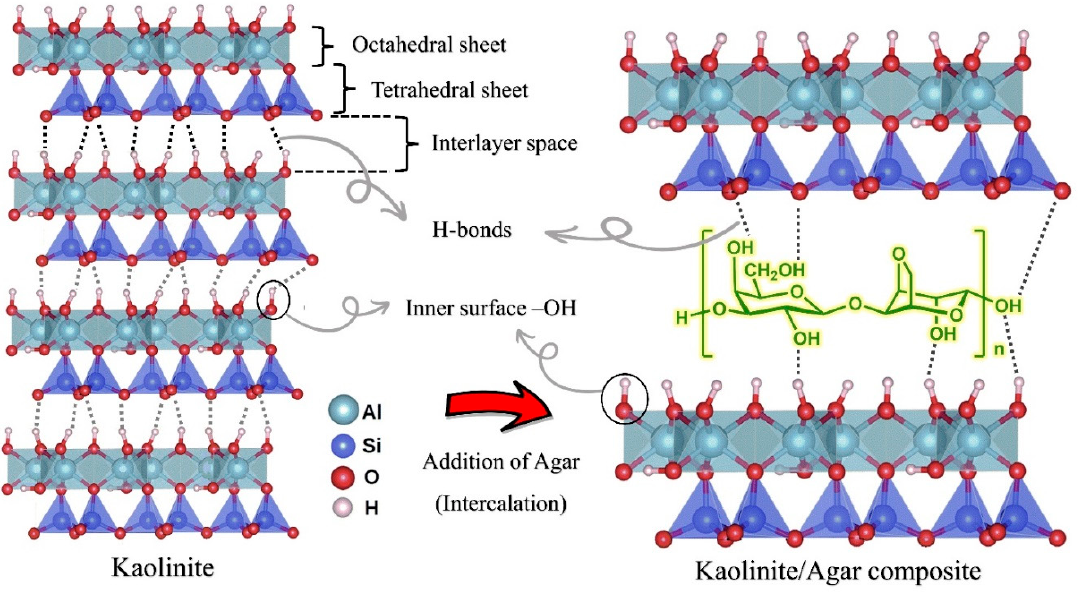
Figure 11. Structure of kaolinite and agar and their interaction.